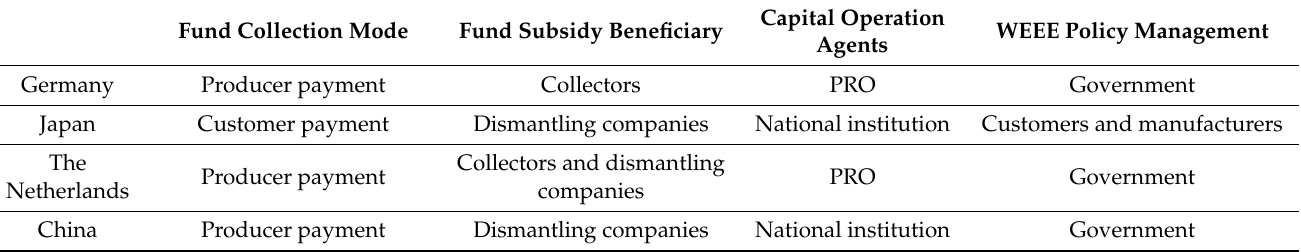
Table 1. Comparative analysis of the different fund operation